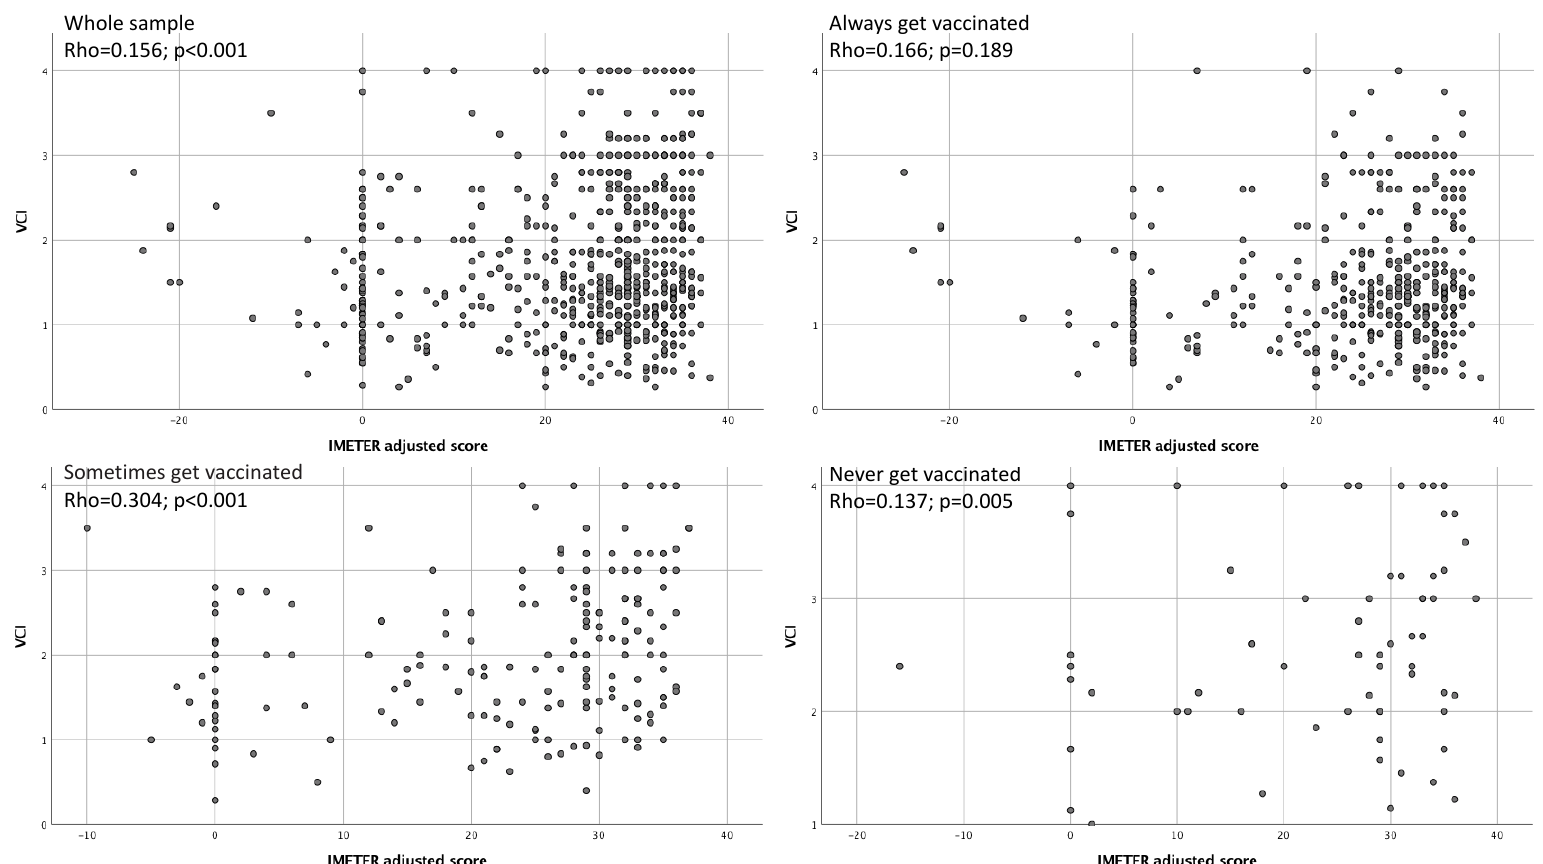
Figure 1. IMETER adjusted-score and Vaccine Confidence Index (VCI): Spearman correlation analysis in the whole sample and by vaccination.